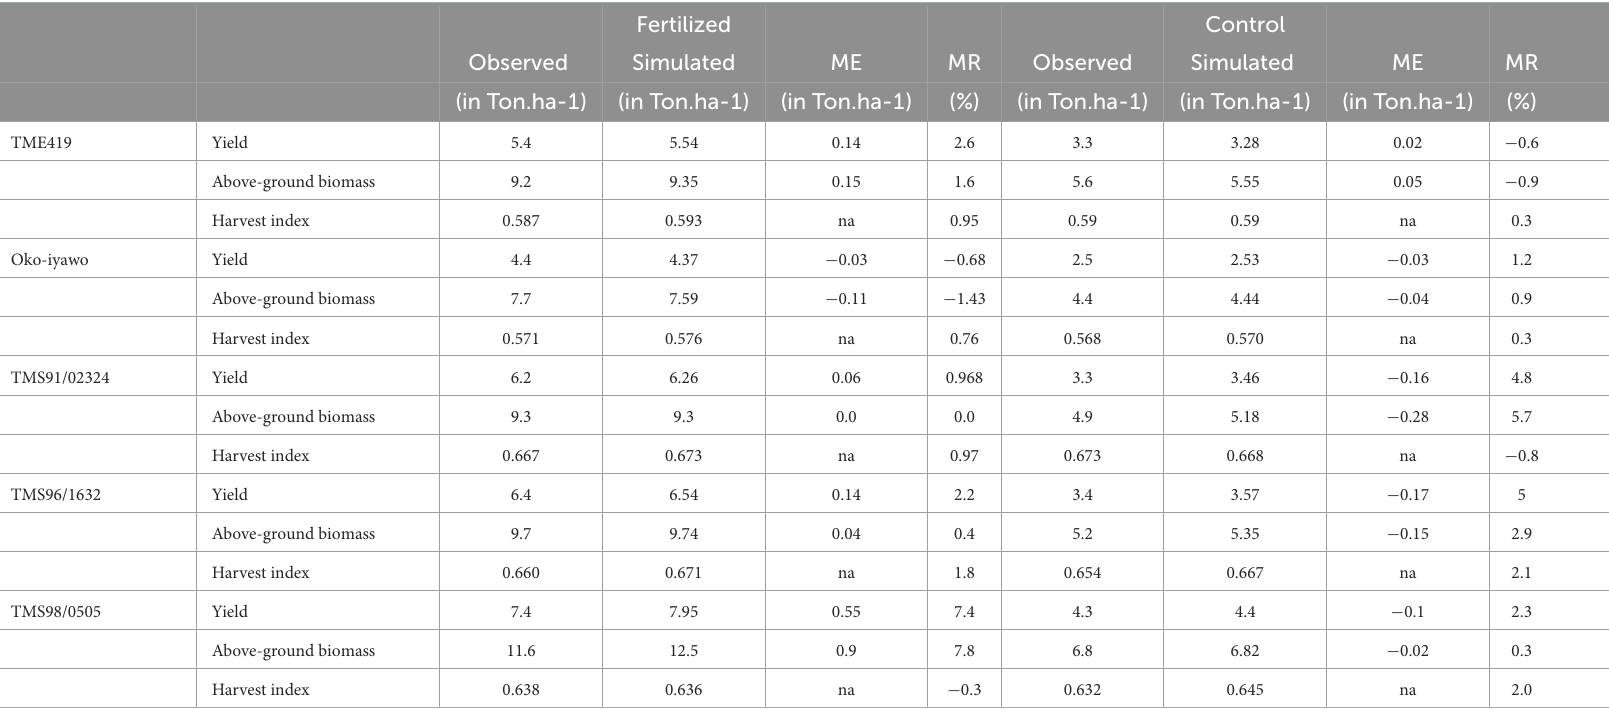
TABLE 2 Observed (in the Ikenne experimental site) and simulated cassava yield dry matter, above-ground biomass (in Ton · ha − 1 ), mean error (ME, in Ton · ha − 1 ), and mean residual error (in %) under control (unfertilized) and fertilized conditions of the five cassava varieties at Ikenne experimental site,